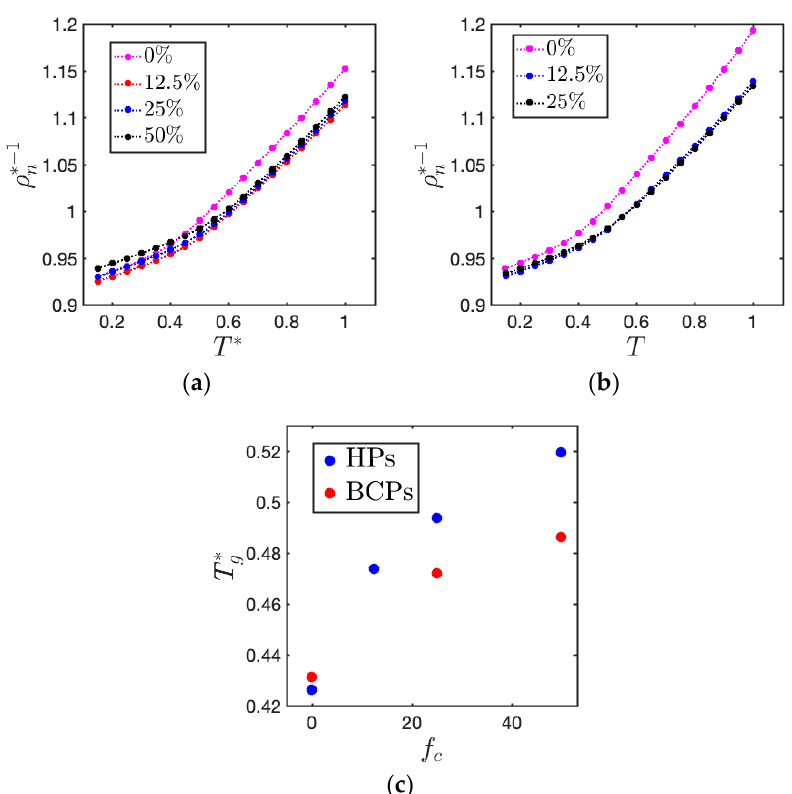
Figure 4. Specific volume of the system ( ρ ∗− 1 n ) as a function of temperature of ( a ) HPs and ( b ) BCPs at di ff erent charge ratio f c , and ( c ) extracted T ∗ g as a function of f c